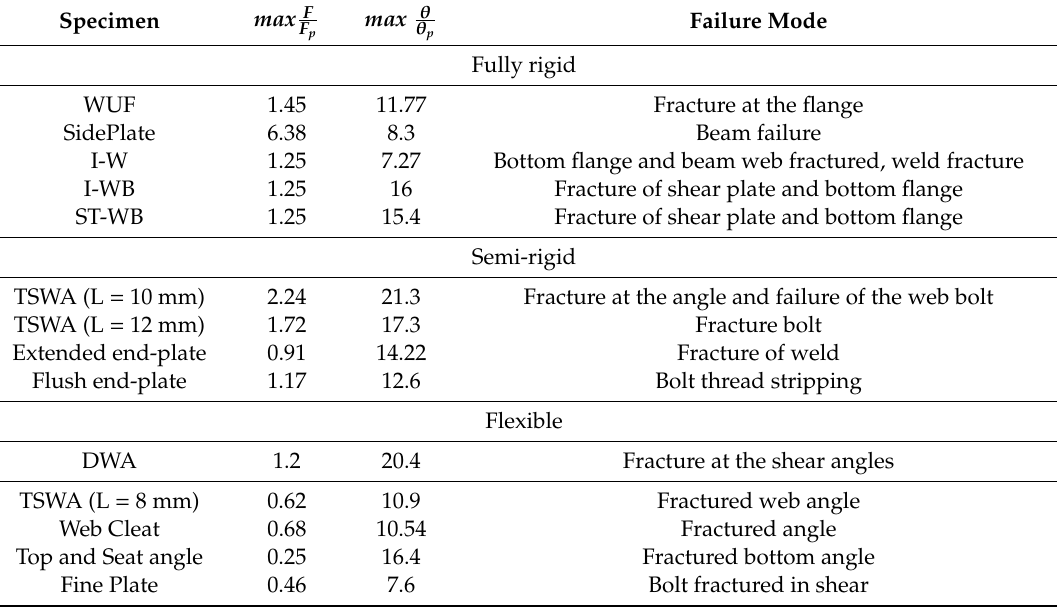
Table 3. Summary of Test